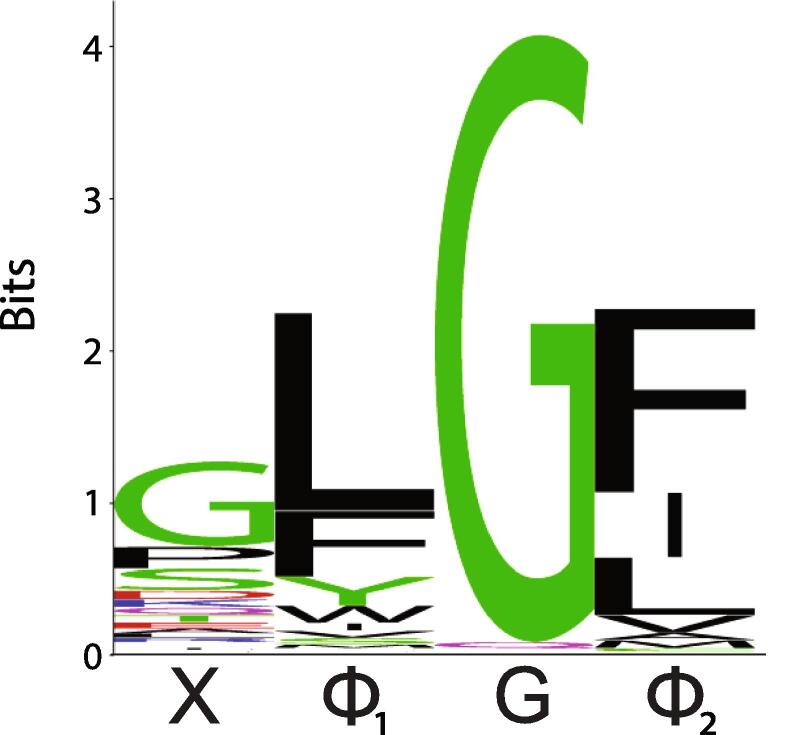
WebLogo analysis of carboxylate-binding loop sequences. Using structural information and sequence alignments, we identified the carboxylate-binding loop sequences of all known human PDZ domains, as reported in Table S3. WebLogo analysis reveals that the most common sequence is GLGF; however, there is substantial variability at the first, second, and fourth positions, which can affect peptide selectivity as previously reported (Amacher et al., 2013).